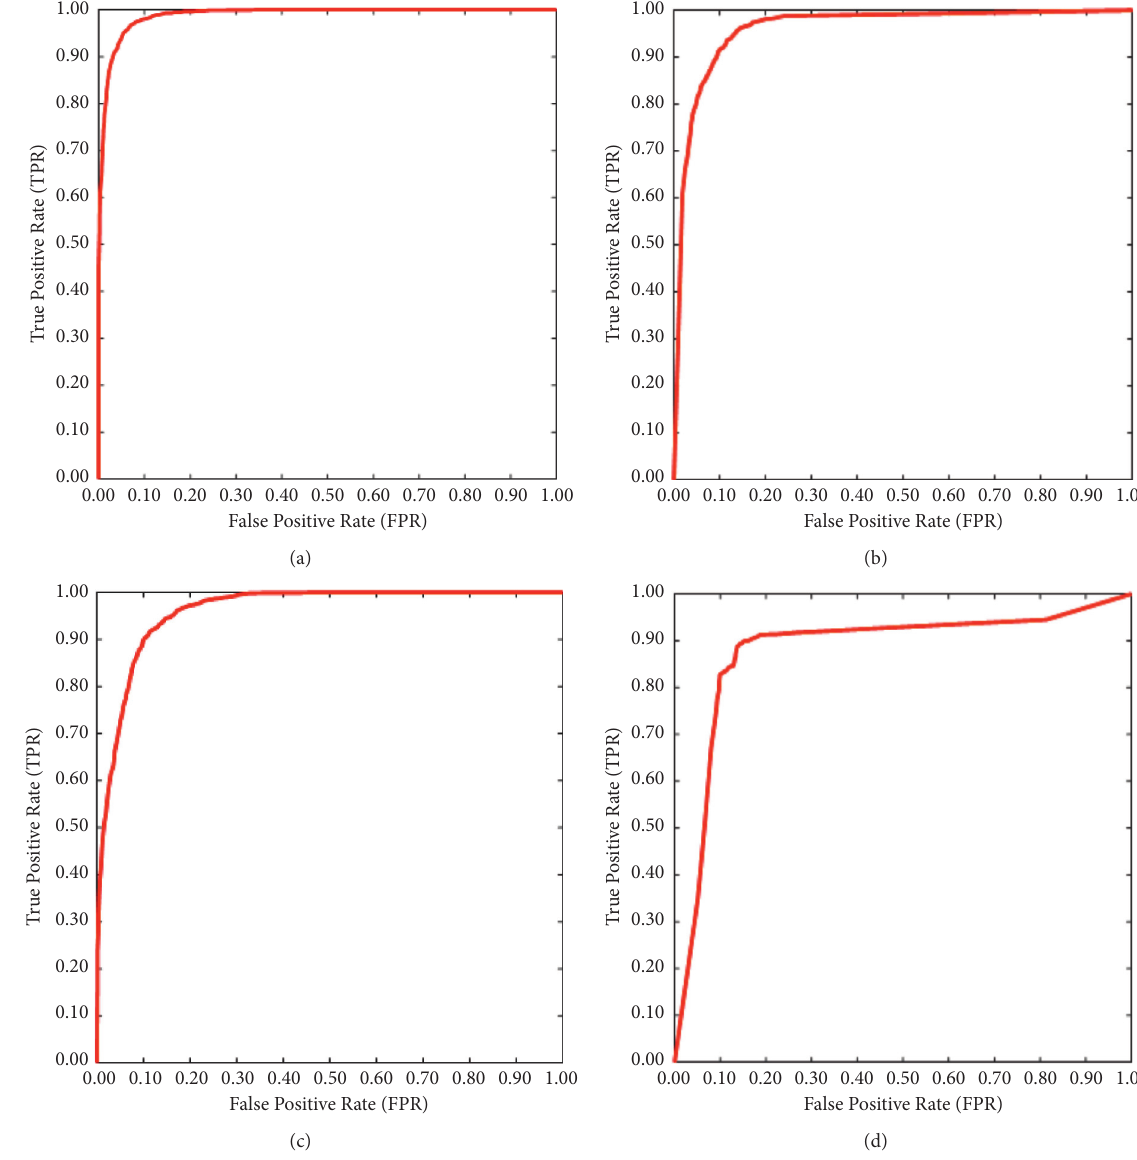
Figure 12: ROCs of the prediction models: (a) FBI-SVC, (b) RVM, (c) RFM, and (d)